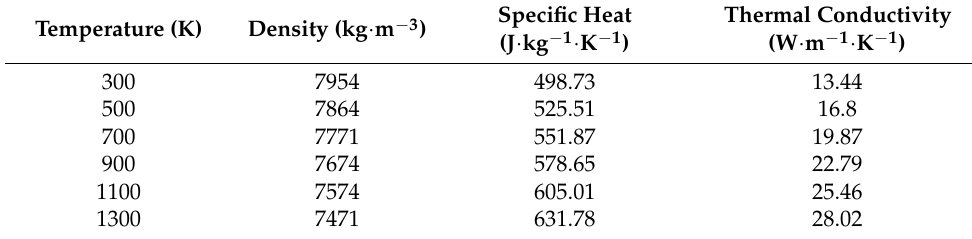
Table 4. 316L thermophysical